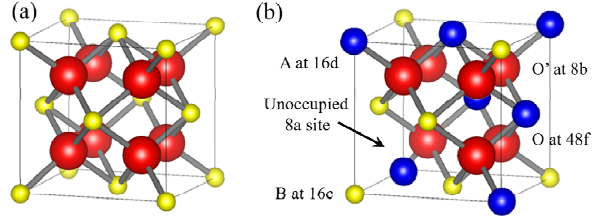
Fig. 15 Crystal structure of the rare-earth zirconate: (a) fluorite structure and (b) pyrochlore structure.